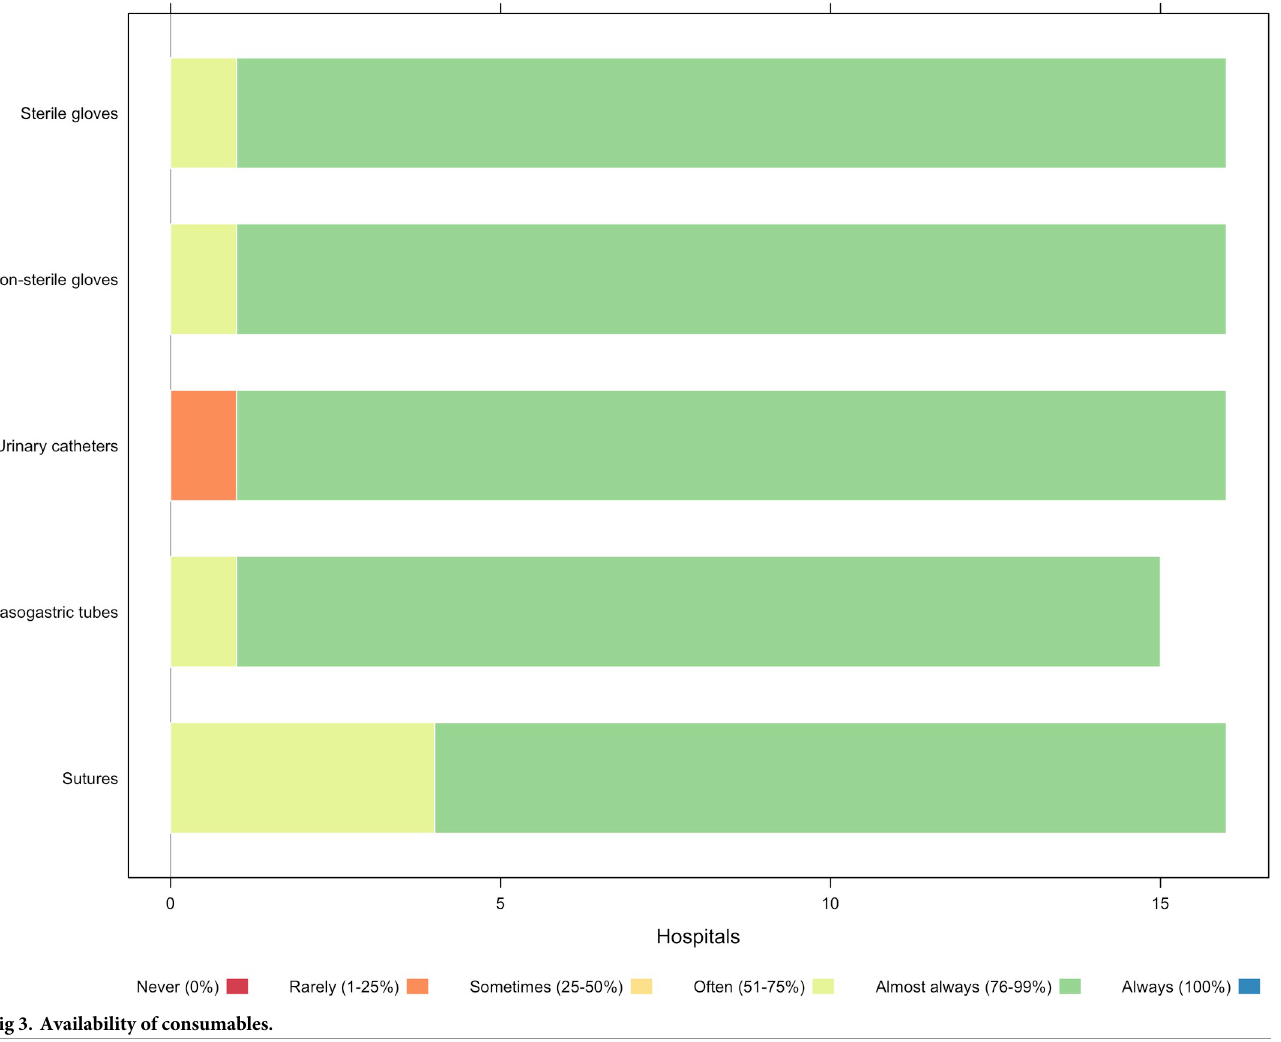
Fig 3. Availability of